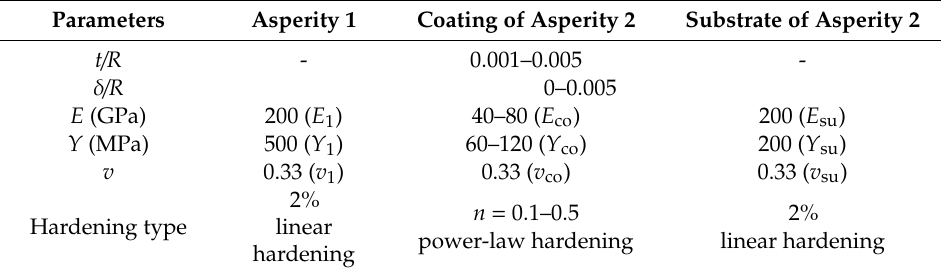
Figure 1. Schematic of the sliding process between two asperities. ( a ) Two asperities in sliding process, ( b ) the forces showing in different directions (including normal and tangential directions). Table 1. Geometrical and material parameters.